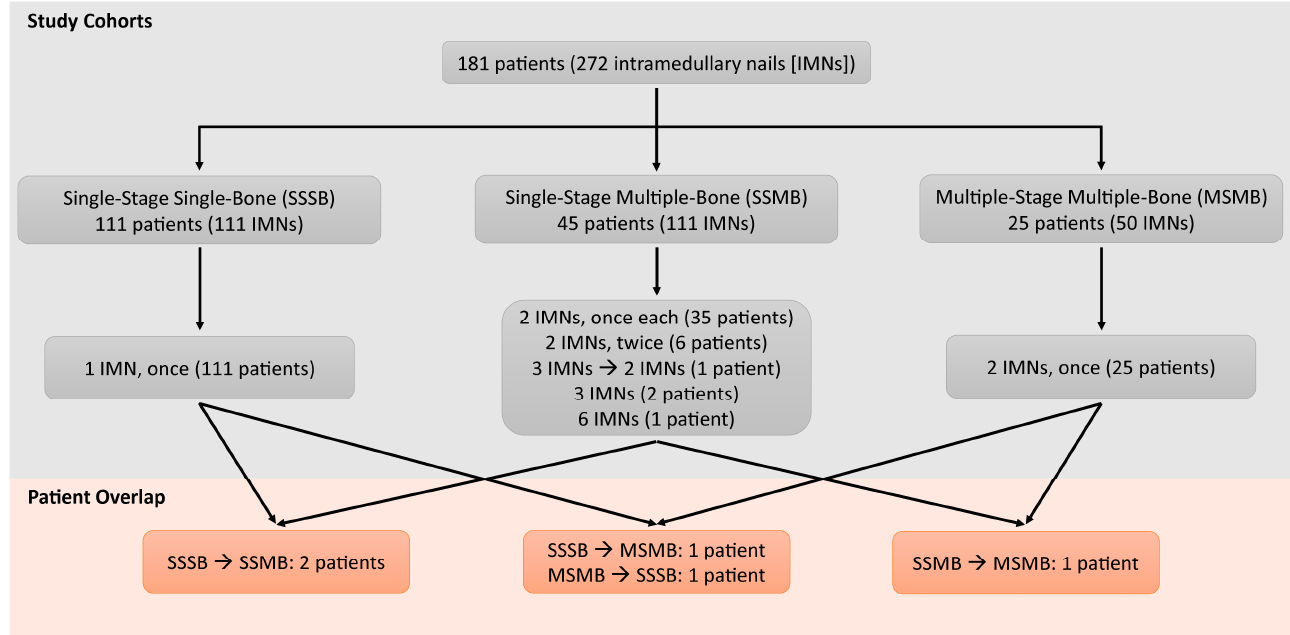
Figure 1. The study cohort and patient group overlap. Seven single-stage single-bone (SSSB) subjects had single intramedullary nails (IMNs) placed twice during separate hospitalizations and were counted as 14 unique events, whereas 13 single-stage multiple-bone (SSMB) patients had their sur- gery preceded or followed by a single-nail insertion during the same hospitalization and were counted in the SSMB cohort for statistical analysis despite them technically undergoing staged pro- cedures. Four SSMB/MSMB (multiple-stage multiple-bone) patients were also considered in